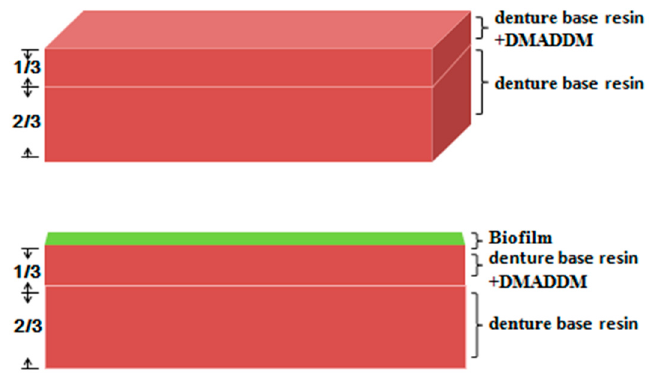
Figure A1. The specimen model for all experiments except for animal experiment.